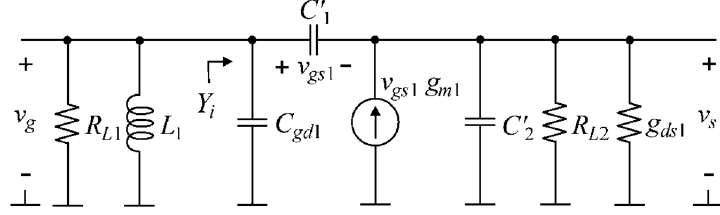
Figure 2. Small ‐ signal model of HSCO shown in Figure 1c. Figure 2. Small-signal model of HSCO shown in Figure